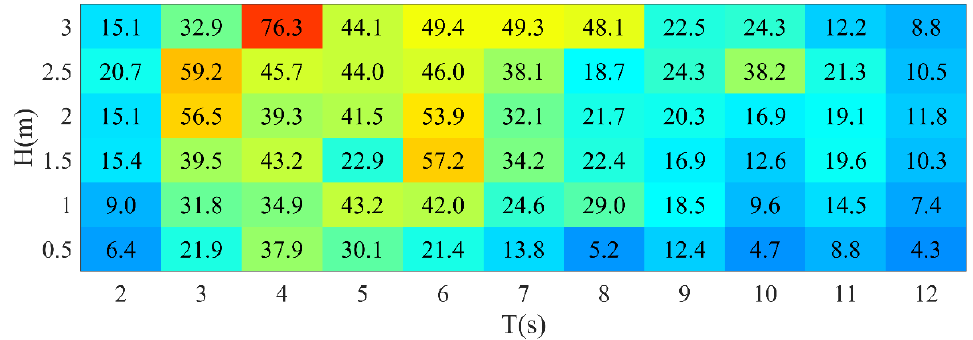
Figure 12. Power generation efficiency of S-PWEC under irregular wave sea conditions. The average power generation efficiency of NOSWEC and S-PWEC under regular and irregular wave sea conditions is shown in Table 4. From the results, adding a slope structure at the bottom of the floating plate can effectively improve its wave energy capture and absorption efficiency, which is meaningful for the development of wave energy conversion devices, which can exchange a smaller cost for a higher yield by adding a slope structure. Table 4. Average power generation efficiency.